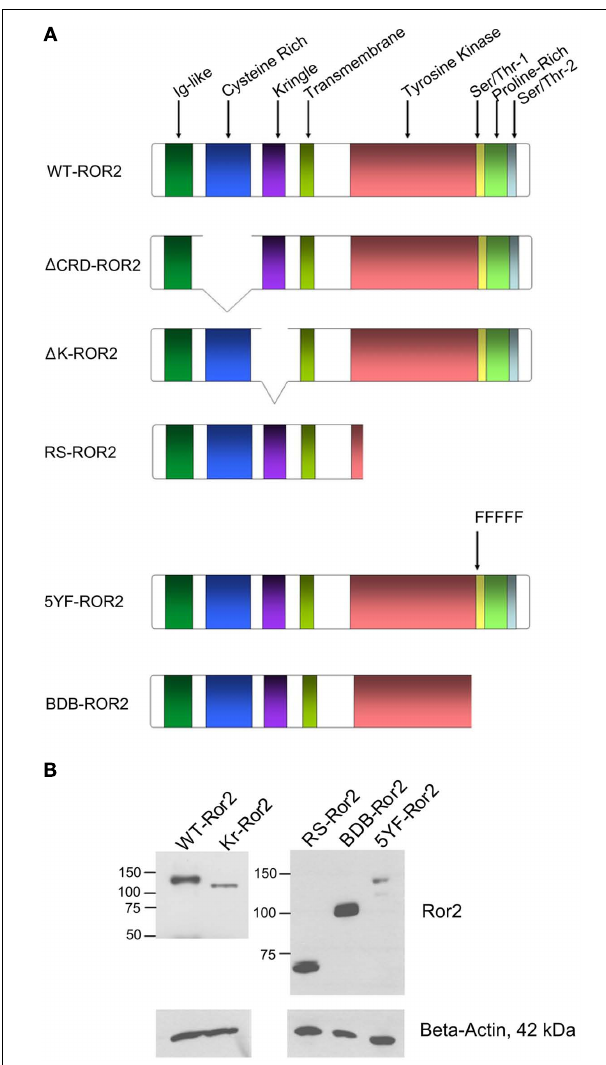
FIGURE 1 | (A) Schematic representation of the Ror2 constructs used in these experiments. Full length Ror2 is characterized by three extracellular domains (Ig-like, cysteine-rich and kringle domains), as well as four conserved intracellular domains (tyrosine kinase, serine/threonine-rich-1, proline-rich, serine/threonine-rich-2 domains).The various Ror2 constructs are characterized by deletions of specific putative domains of Ror2.The Δ CRD Ror2 contains a deletion of the cysteine-rich domain. In the Δ K Ror2 construct, the kringle domain has been truncated. In RS Ror2, a majority of the tyrosine kinase domain, as well as regions distal to this domain have been deleted.The 5YF Ror2 construct contains five substitution mutations in the Ser/Thr-1 region, where five tyrosine residues have been replaced by phenylalanines.The BDB Ror2 construct contains a deletion of the Ser/Thr-1, proline, and Ser/Thr-2 rich regions. (B) Expression levels ofWT Ror2, Δ K, RS, BDB, and 5YF in HT29 cells with beta-actin as a loading control.